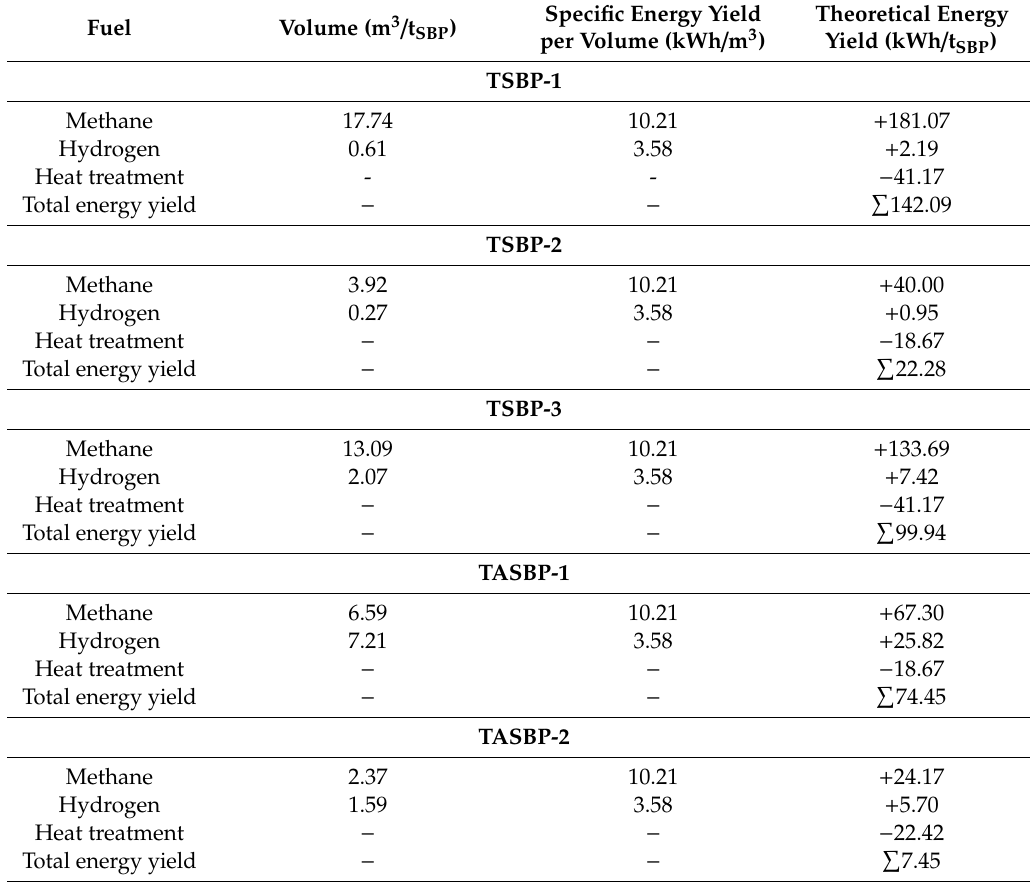
Table 6. Simplified energy balance for experimental